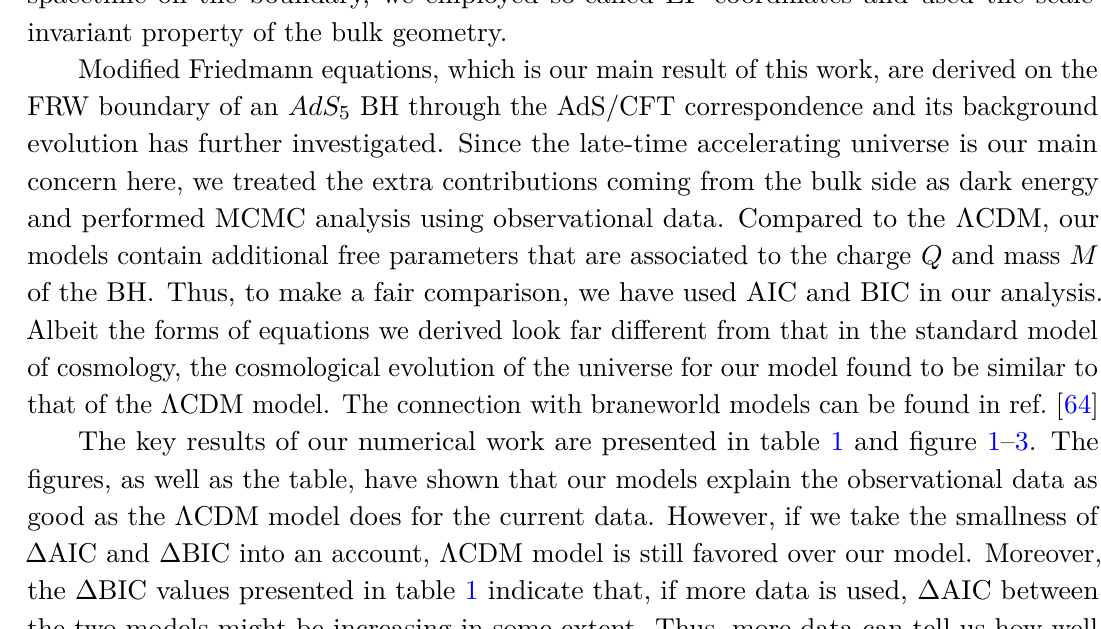
Figure 3 . The redshift evolution of (4.2) in light of the observational data [48], where the numerical inputs for each model are from table 1. The Λ CDM model with H ( z ) = H 0 is reflected in the solid black